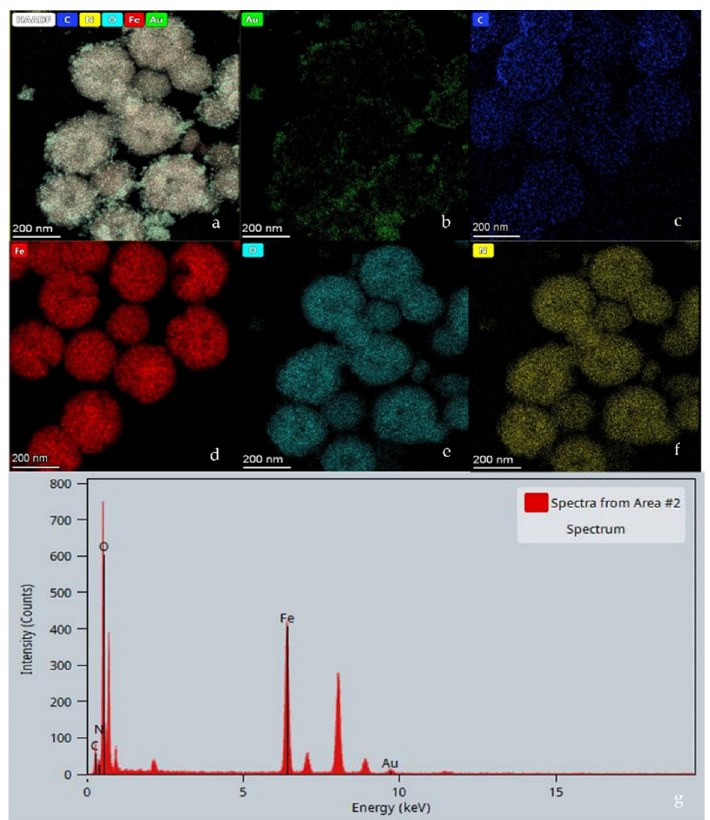
Figure 4. TEM mapping and EDS of Fe 3 O 4 @PDA/Au/GO nanocomposites. ( a ) the elemental mappings of Fe 3 O 4 @PDA/Au/GO; ( b ) the elemental mappings of Au; ( c ) the elemental mappings of C; ( d ) the elemental mappings of Fe; ( e ) the elemental mappings of O; ( f ) the elemental mappings of N; ( g ) EDS of Fe 3 O 4 @PDA/Au/GO.